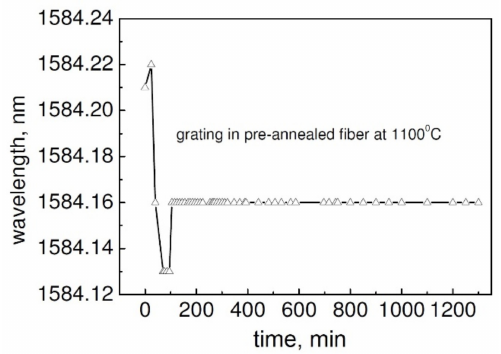
Figure 13. Bragg wavelength drift of a Type II FBG in pre-annealed fiber (reproduced from